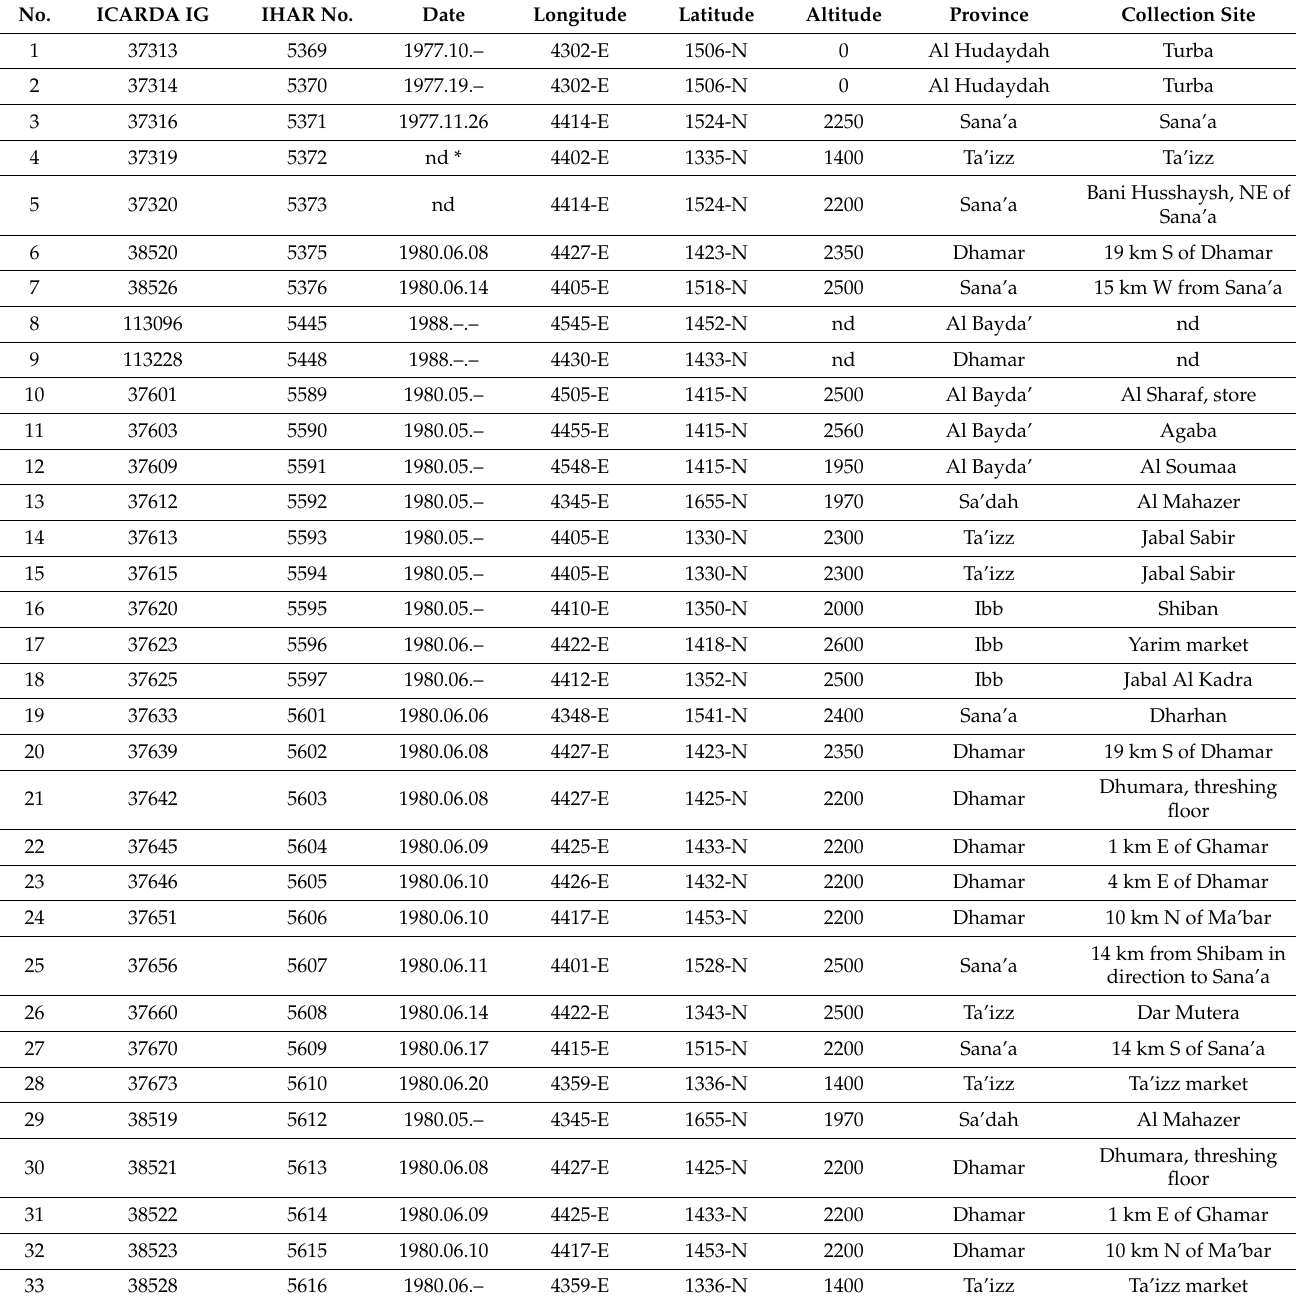
Table 1. Collection data of 33 landraces collected in